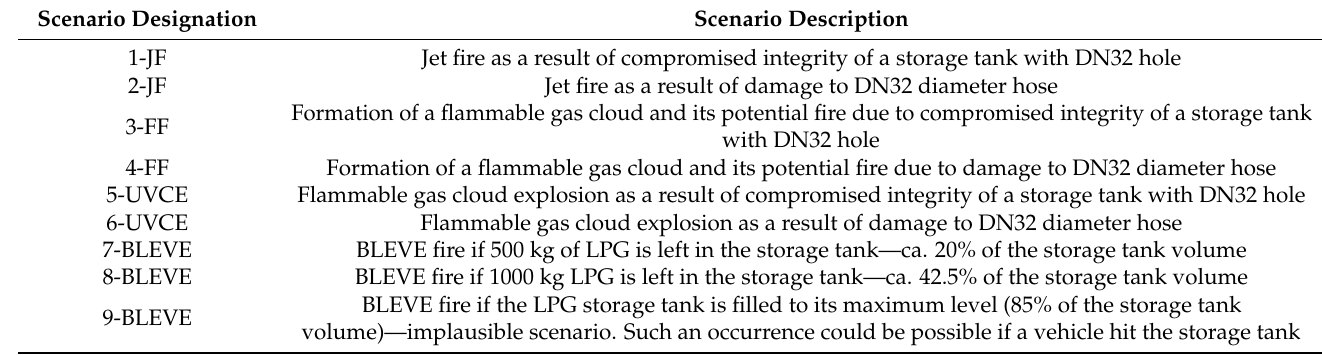
Table 5. Failure